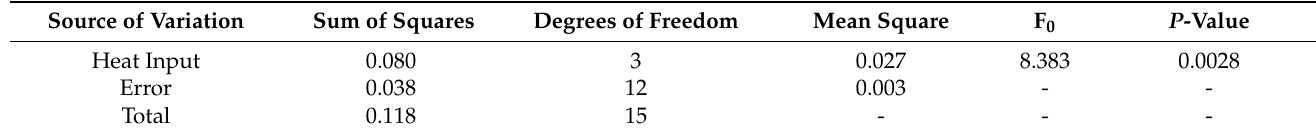
Table 10. ANOVA table for width W.